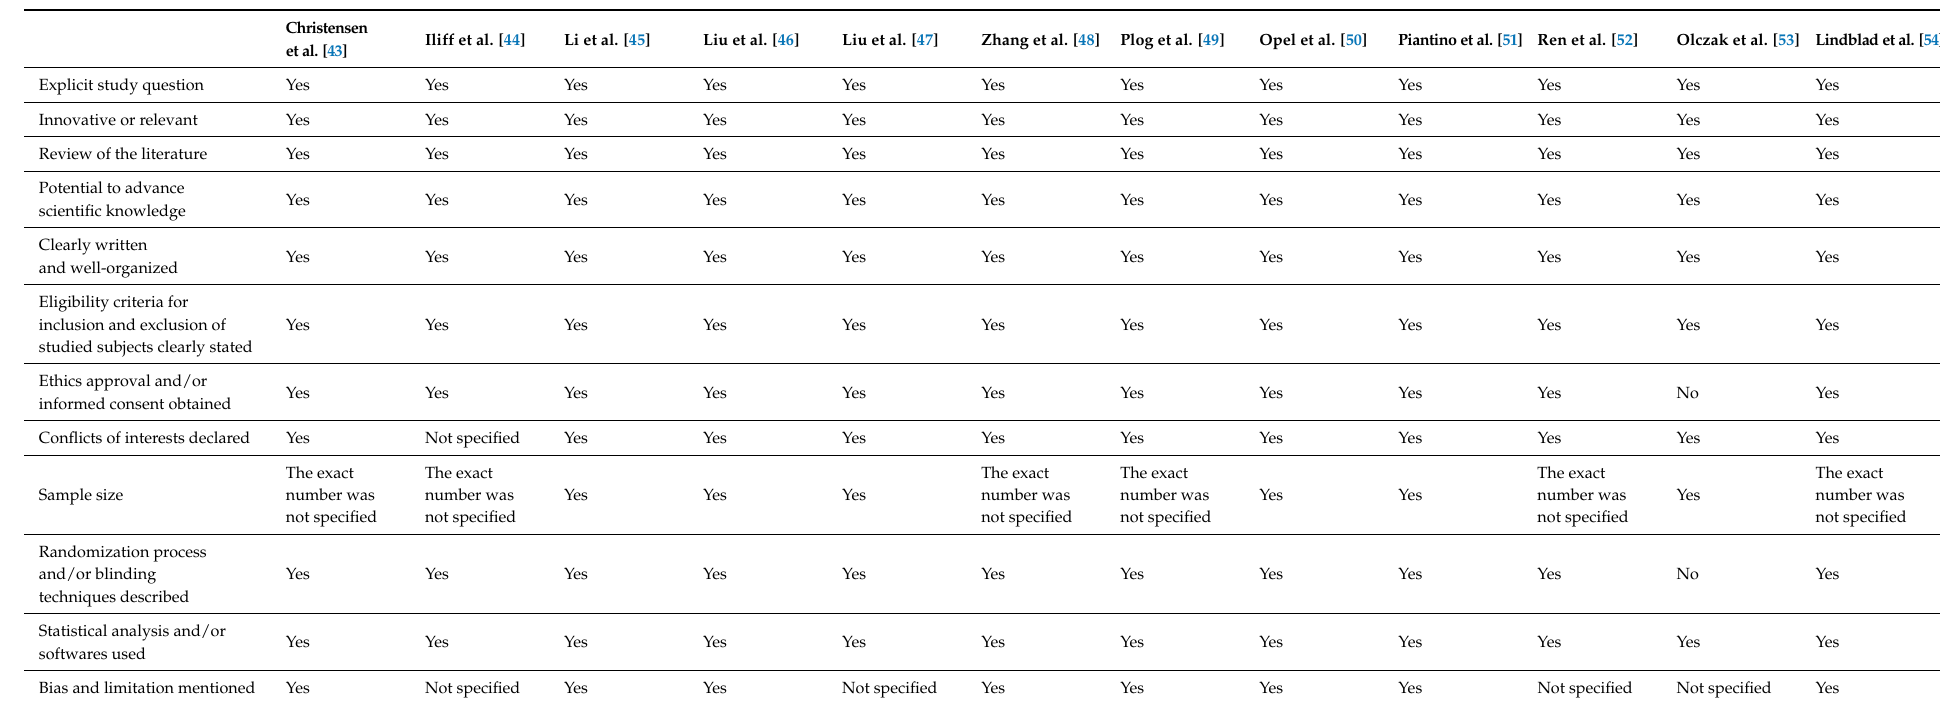
Table 1. Critical review of the selected manuscript